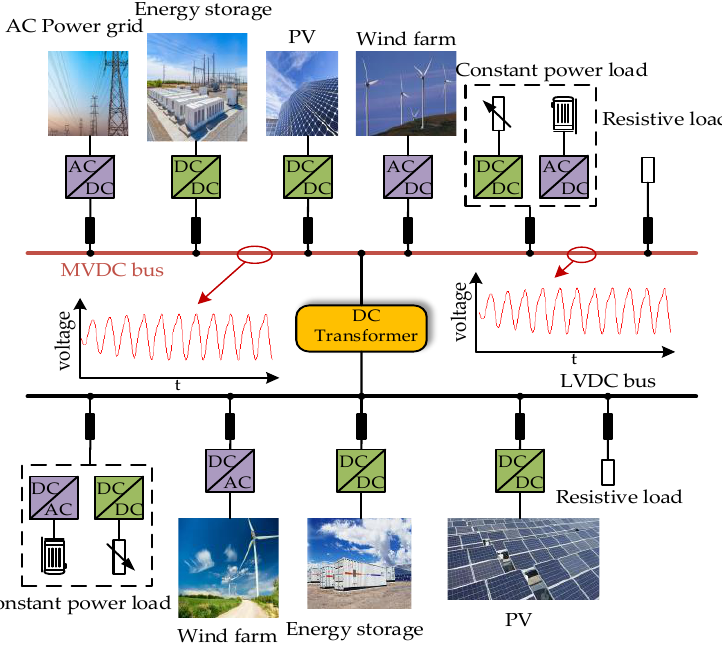
Figure 1. A typical DC distribution system.